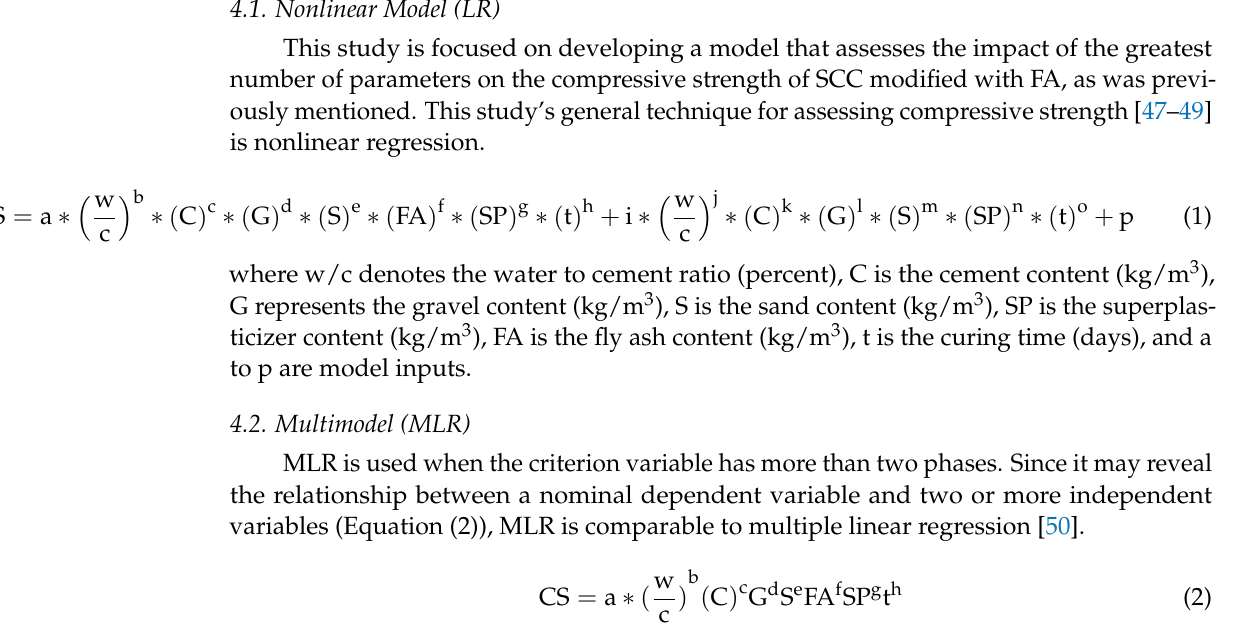
Figure 5. Correlation matrix for the model input parameters and target.